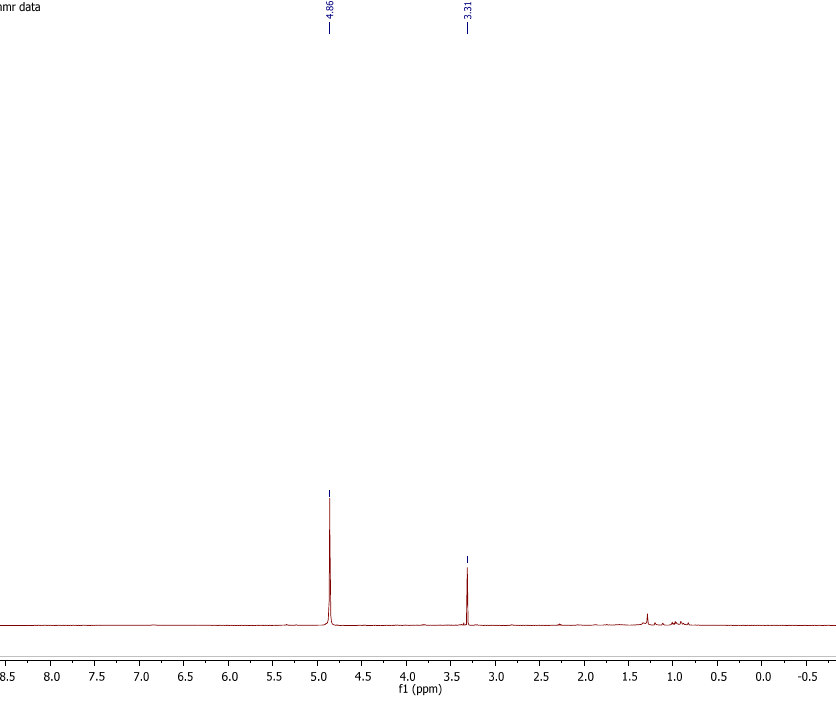
Figure 8. The 1 H-NMR spectrum for the crude acid